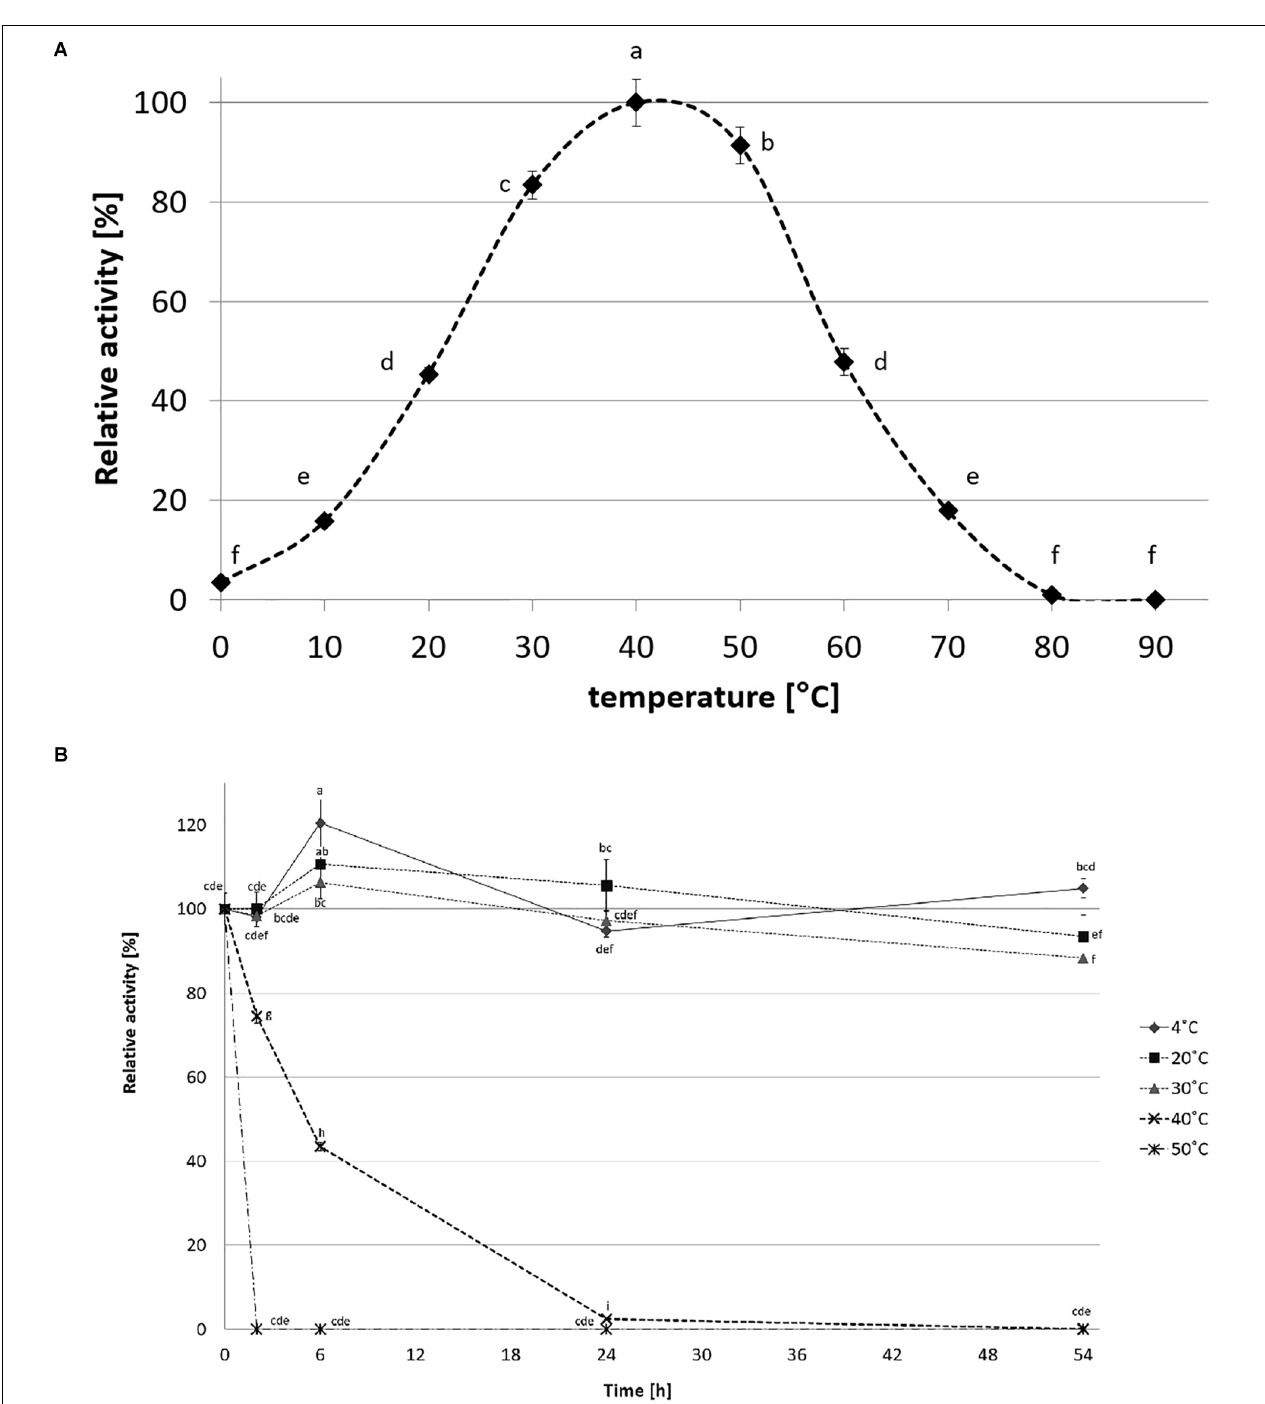
FIGURE 8 | The effect of temperature on recombinant CelRH5 activity (A) and stability (B) . Activity toward OBR-HEC was determined at 20 mM sodium phosphate buffer pH 6.5. The error bars represent the standard deviation ( n = 3) and different letters mean statistically significant differences.